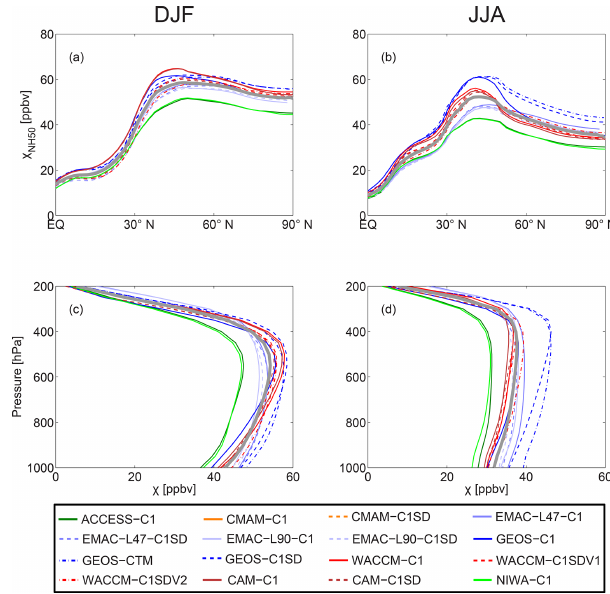
Figure 11. As in Fig. 2 except for